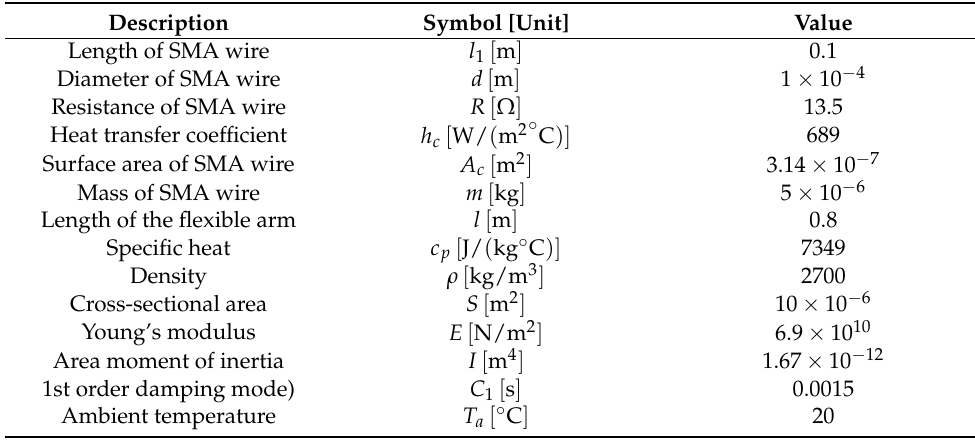
Figure 2. Schematic diagram of the experimental setup. Table 1. Physical parameters of the flexible arm with SMA